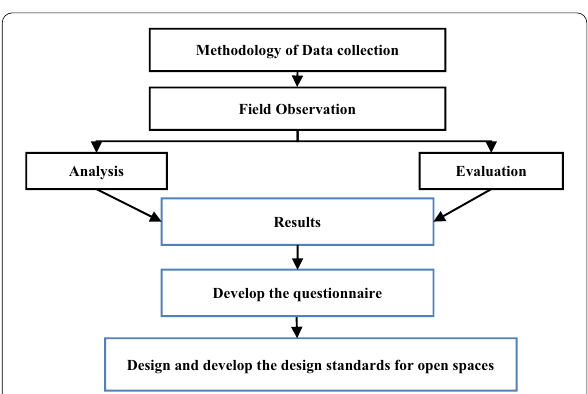
Fig. 3 The methodology of data collection, Source: The